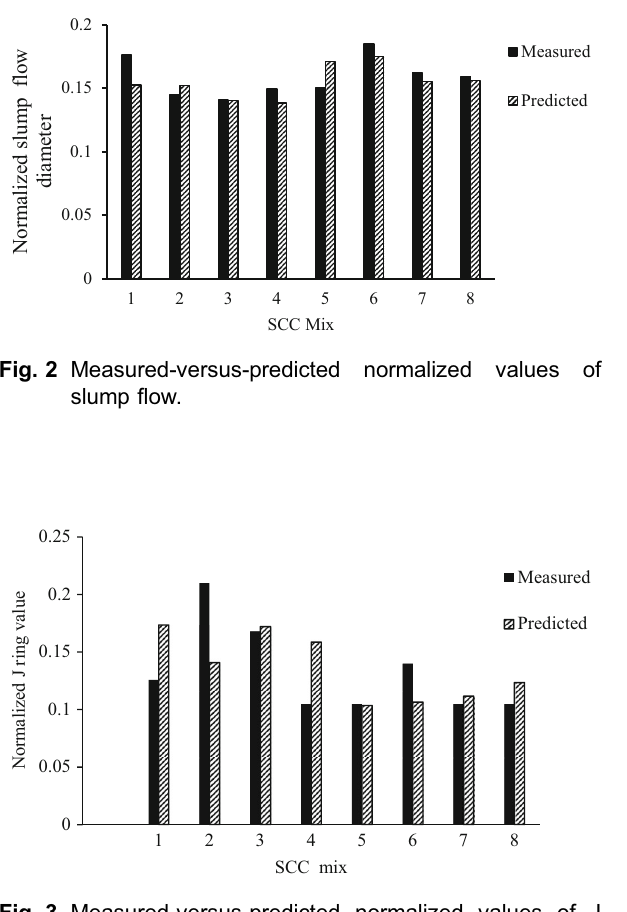
Fig. 3 Measured-versus-predicted normalized values of J ring.